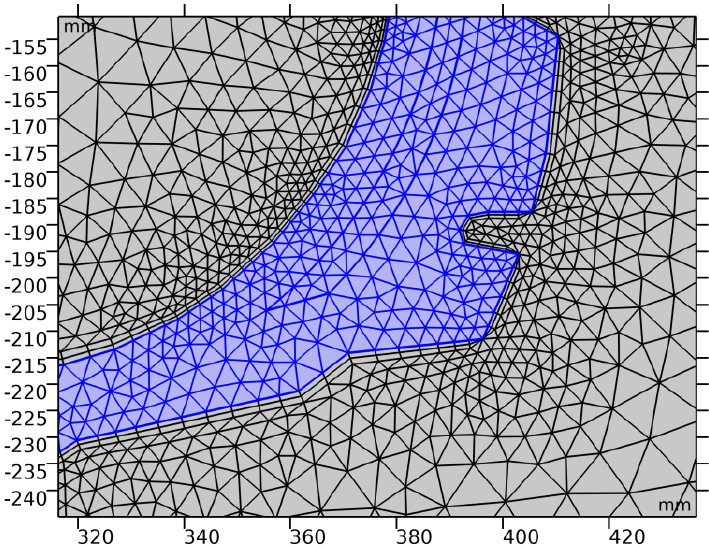
Figure 2. Fragment of the grid model for COMSOL computations.